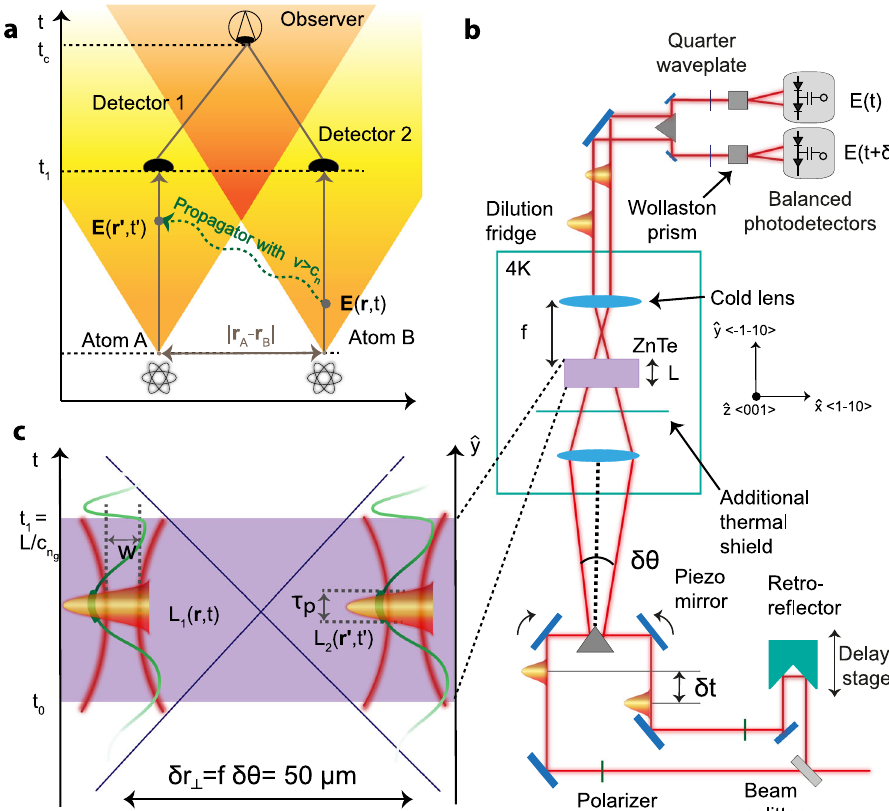
Fig. 1 Nonlocal measurement of quantum-vacuum induced correlations. a Statistical correlations between two atoms A and B can be detected even before an exchange of information between the two can occur. This can be ascribed to their interaction with the quantum vacuum, whose correlation at different space-time points ( r , t ) and ( r ', t ') is non-vanishing even for non-causally connected regions (in yellow). b A delay stage controls the temporal distance δ t between the ultrashort probes, while a piezo mirror controls their relative spatial distance δ r through their relative angle δθ . The zinc telluride ? (ZnTe) detection crystal is placed in a 4 K environment to isolate it from thermal radiation. The change in polarization of each probe separately is measured by ellipsometry. c The interaction with the vacuum occurs when the 195fs long pulses enters and leaves the non-linear